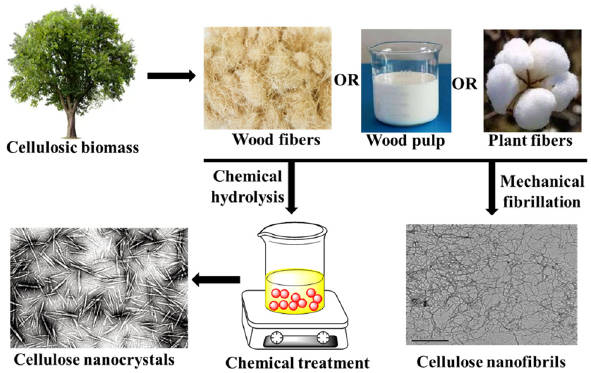
Figure 1: Types of nanocellulosic materials from woody/non - woody